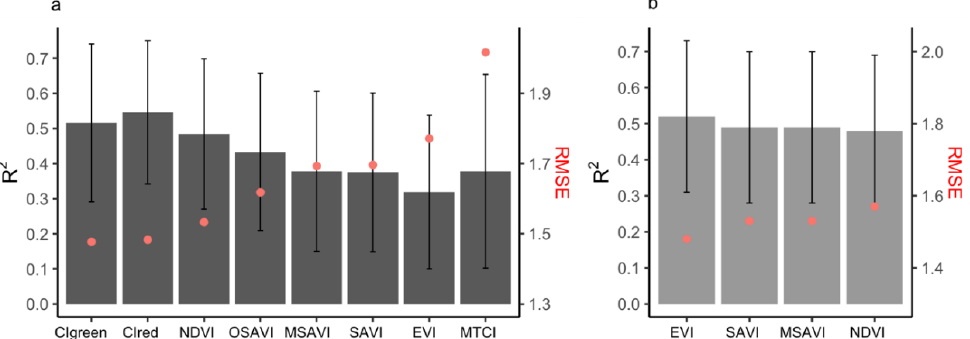
Figure 5. The accuracy (R 2 and RMSE) of the empirical models using the seasonal maximum VIs listed in Table 2, using ( a ) Sentinel-2 seasonal maximum VIs (only top eight shown) at spatial resolution of 10 m and ( b ) PlanetScope seasonal maximum VIs at spatial resolution of 3 m. Error bars indicate the standard deviation of R 2 assessed from the 10-fold cross-validation realizations, whilst the red dots refer to the RMSE (t/ha).